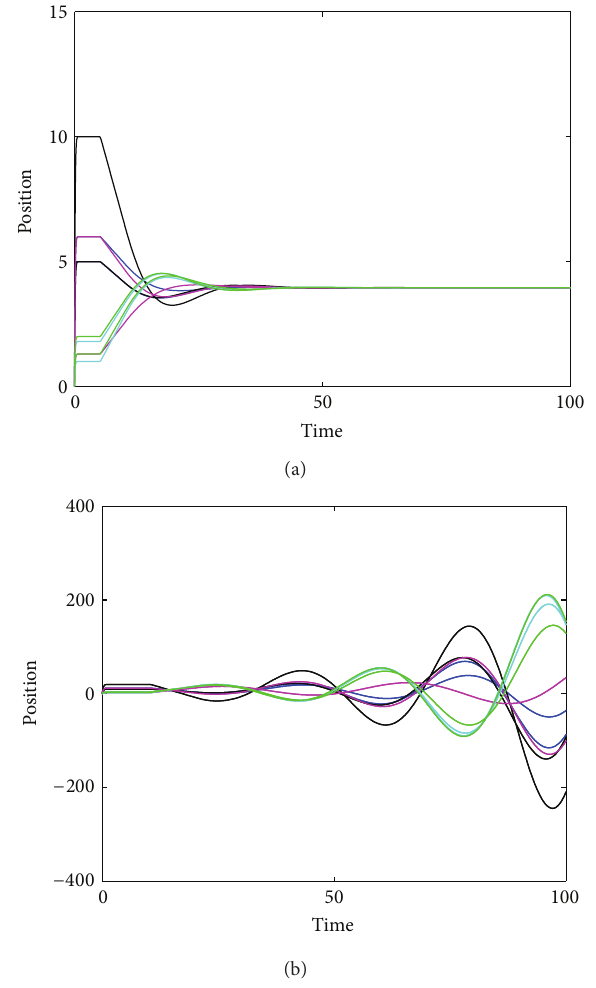
Figure 4: The position states in system (35) with the symmetric topology as 𝜏 = 5,𝛾 = 10 and 𝜏 = 10, 𝛾 = 5